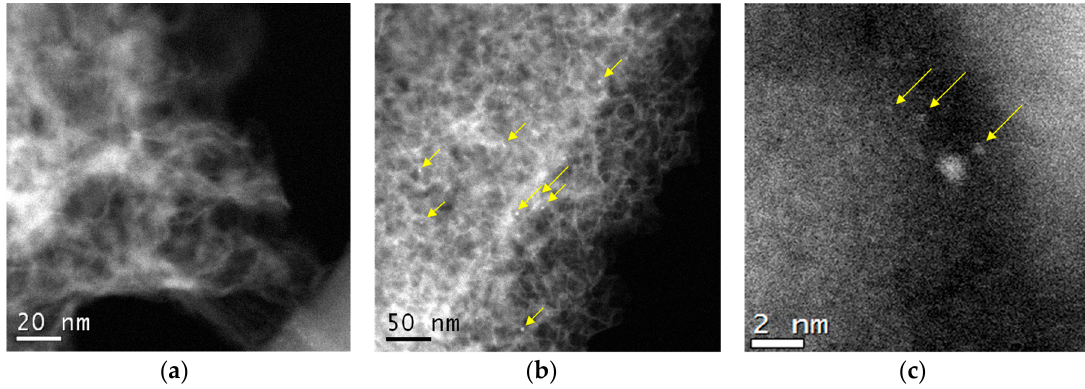
Figure 4. HAADF/STEM images of the Ni/CN-1073 catalyst after the reaction: ( a ) region without Figure 4. HAADF / STEM images of the Ni / CN-1073 catalyst after the reaction: ( a ) region without nanoparticles, ( b ) and ( c ) regions with nanoparticles and clusters. nanoparticles, ( b ) and ( c ) regions with nanoparticles and